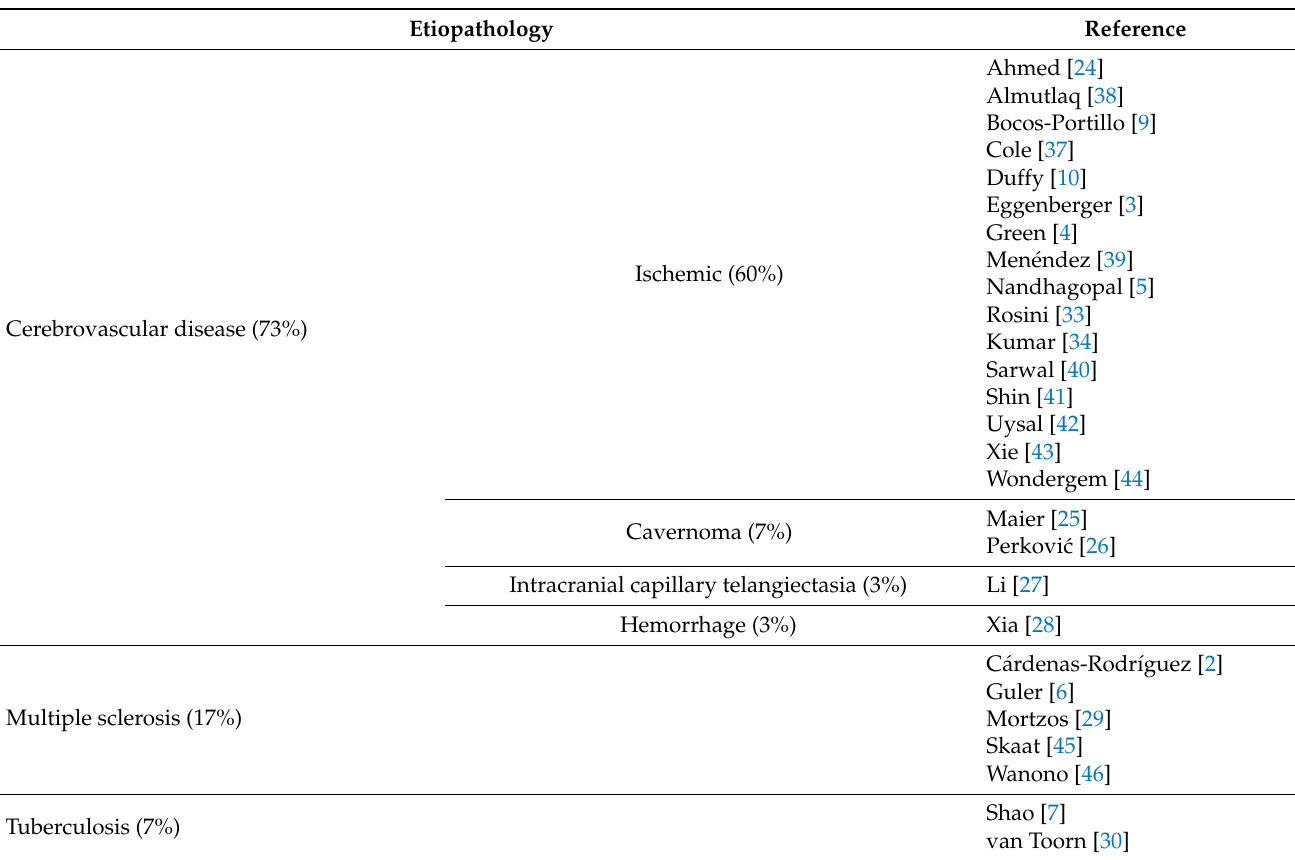
Table 1. Literature